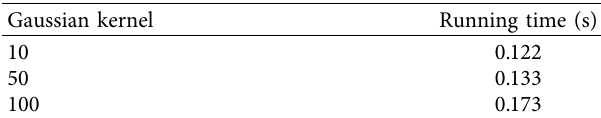
Table 1: Running time of DMPs in different Gaussian kernels. Gaussian kernel Running time